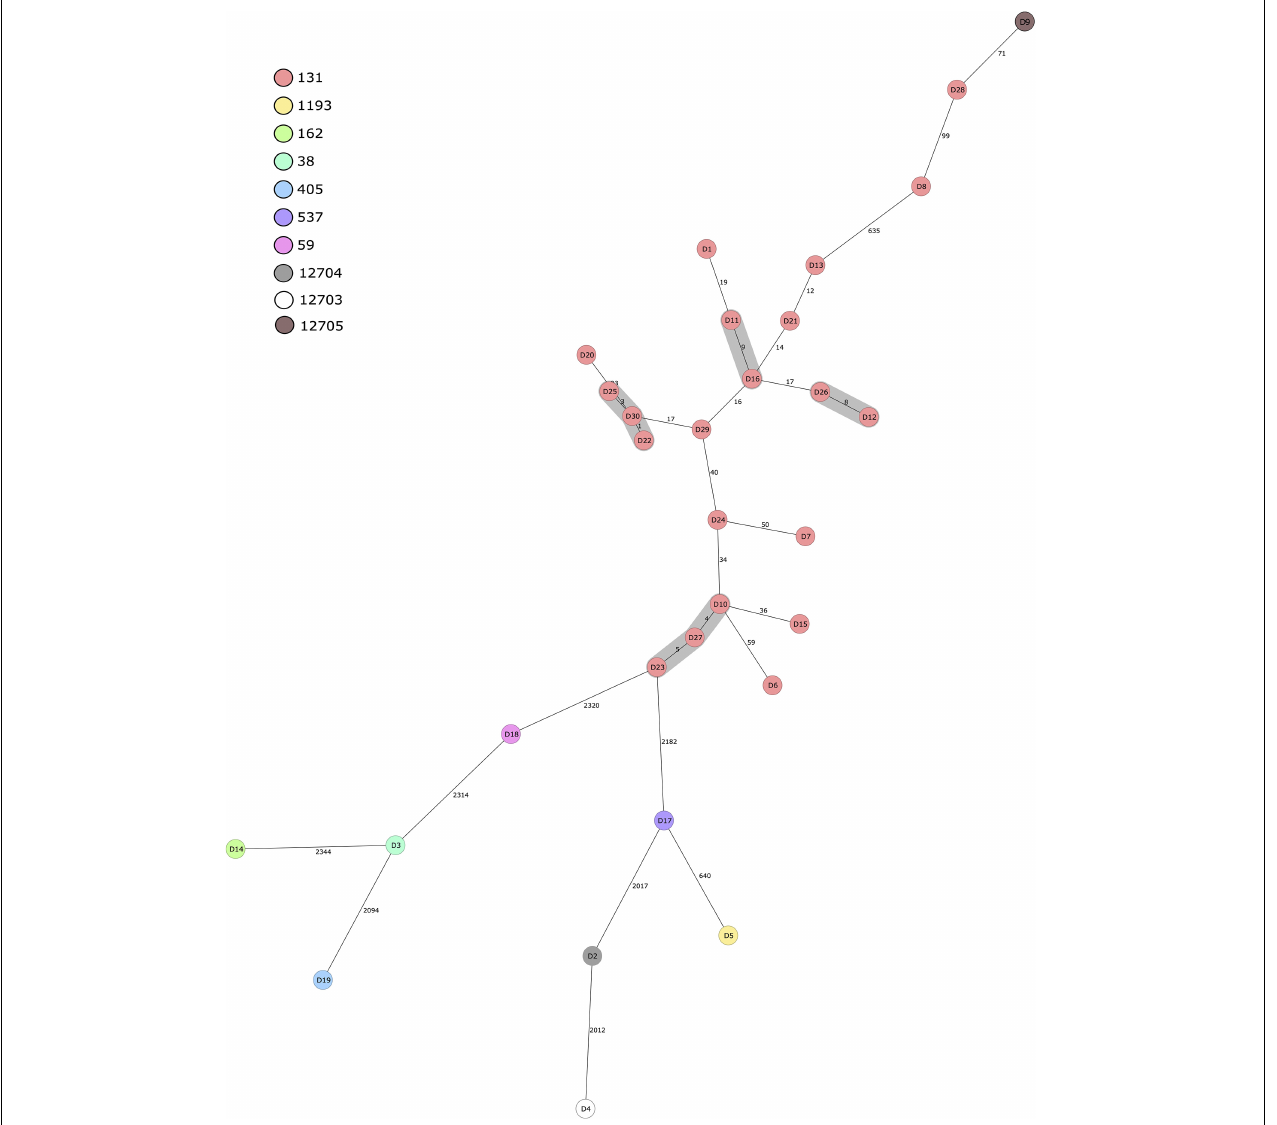
FIGURE 2 | Minimum spanning tree of 30 human ESBL-producing Escherichia coli isolates obtained from patients in Eastern Finland during 2018–2020. Tree was calculated in Ridom SeqSphere+ with 2513 core genome multilocus sequence typing (cgMLST) targets and 7 E. coli MLST Warwick targets (pairwise ignoring missing values, logarithmic scale). Nodes are colored according to sequence type. Number of allelic differences between isolates are indicated on the connecting lines. Clusters are defined as ≤ 10 allelic difference and shaded in gray.